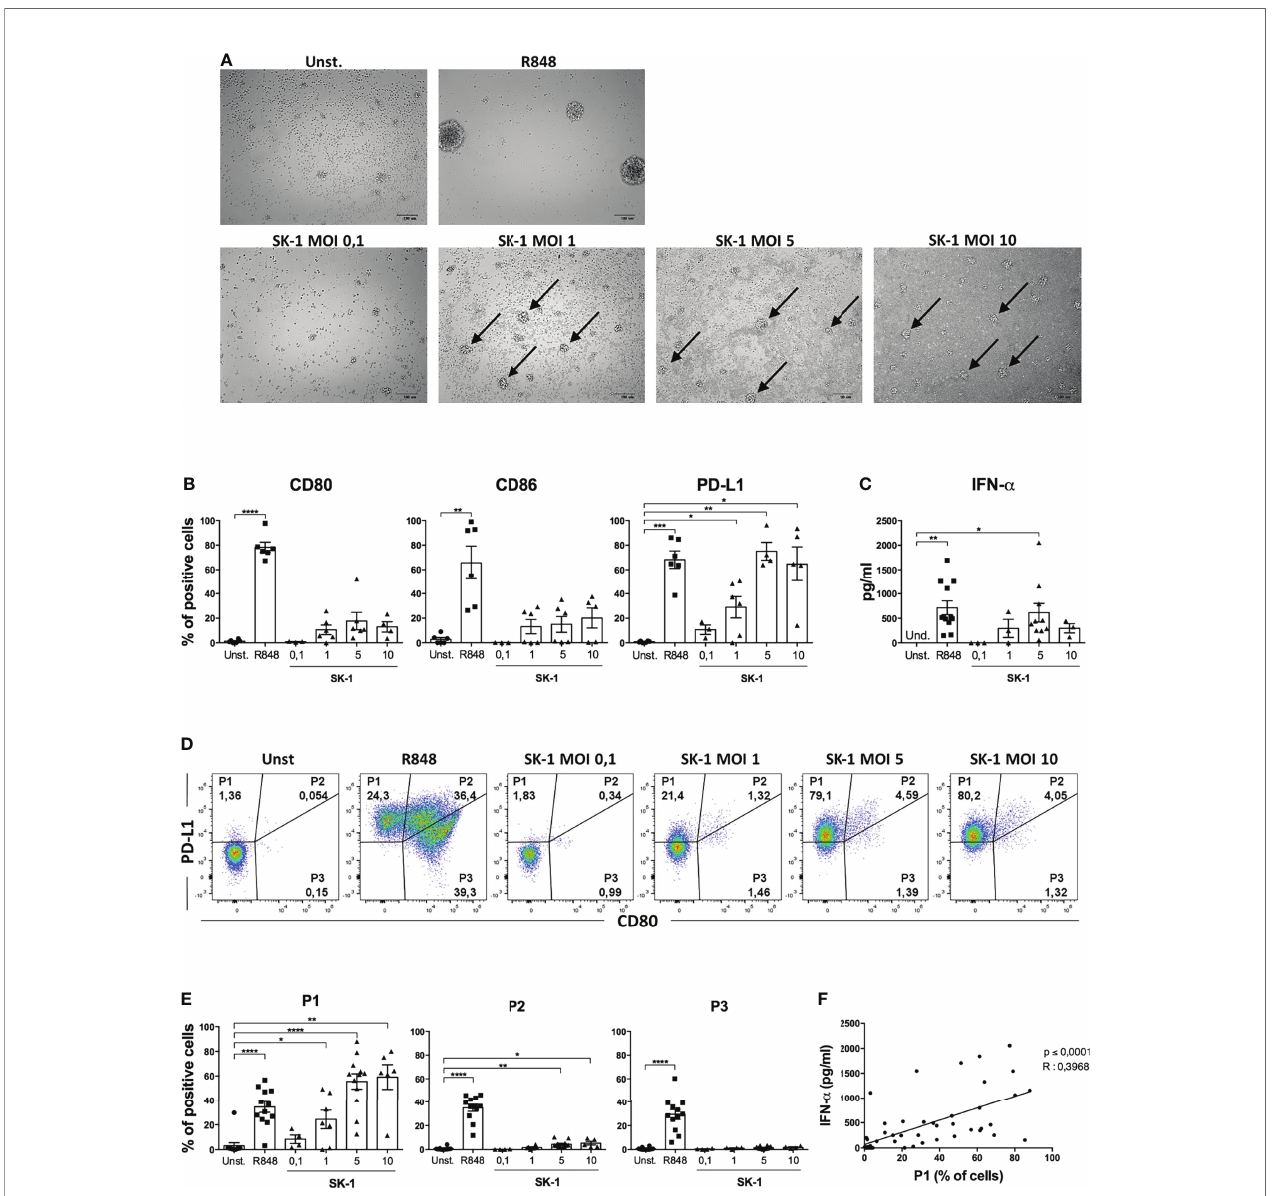
FIGURE 2 | SK-1 induces the differentiation of the P1 subpopulation of human plasmacytoid dendritic cells (pDCs). Human pDCs puri fi ed from the peripheral blood of healthy donors were cultured for 48 h without stimulation (Unst.), with R848 (1 m g/ml) as positive control, or with the laboratory strain of Saccharomyces cerevisiae SK-1 at different multiplicity of infection values (0.1 – 1 – 5 – 10; colony-forming unit SK-1/pDC). Photos by optical microscopy show cell clusters, indicated by arrows, formed by pDCs upon activation. The pictures are representative of three independent experiments, each from a different donor (A) . The expression of molecules CD80, CD86, and PD-L1 was analyzed by fl ow cytometry and reported as the percentage of positive cells (B) . Levels of IFN- a were measured in the culture supernatants by ELISA assay (C) . The expression of PD-L1 and CD80 was analyzed by fl ow cytometry. Representative plots show the percentage of three pDC subpopulations (D) , and the graphs show the corresponding quanti fi cation of more experiments (E) . Data in (B , C , E) are the mean of six or more independent experiments, each from different donors. Error bars represent SEM. One-way ANOVA was used to compare different experimental conditions (*= p -value ≤ 0.05; **= p -value ≤ 0.01; ***= p -value ≤ 0.001; ****= p -value ≤ 0.0001). The percentages of P1 subpopulation, obtained from all experimental conditions of 4 independent experiments, were correlated to their IFN- a levels using Pearson correlation (F) . The R value indicates the correlation coef fi